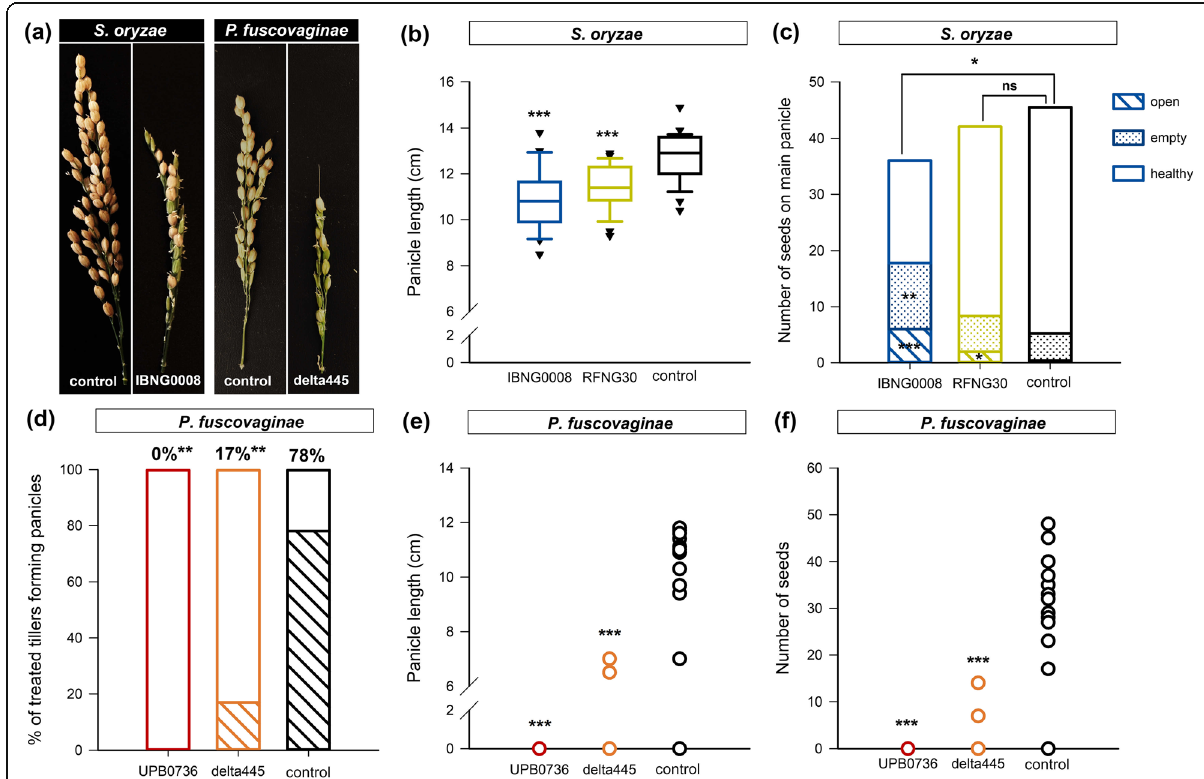
Fig. 7 Grain yield parameters of Sarocladium oryzae and Pseudomonas fuscovaginae infected plants. The main tiller of 7 weeks old Kitaake rice plants was inoculated with S. oryzae or P. fuscovaginae. IBNG0008 is shown in dark blue, RFNG30 in light green and the healthy control, inoculated with a healthy rice grain, in black. P. fuscovaginae wild type strain UPB0736 is shown in red, delta445 in orange and as a healthy control, shown in black, a sterile saline solution was injected. ( a ) A fully ripened panicle, 6 or 8 weeks after inoculation with respectively S. oryzae and P. fuscovaginae. ( b ) Boxplots represent the length of the main panicle and ( c ) stacked bars show the average amount of open, empty and healthy seeds on the main panicle of plants inoculated with S. oryzae . Yield parameters of plants inoculated with P. fuscovaginae are represented by ( d ) stacked bars showing the proportion of the inoculated tillers forming a panicle and dots represent the length of the main panicle ( e ) or the amount of seeds produced by the main panicle of each sample ( f ). The boxplots show the median with the first and third quartile, the whiskers show the minimum and maximum values. Outliers and extreme values are represented by crosses. These data show the results of one experiment with 25 replicates ( b-c ) or 18 replicates ( d-f ). Conditions that differ significantly from healthy control plants are represented by asterisks (Mann Whitney or Mood ’ s Median, n = 18 or n = 25, α = 0.05 ( a-c, e-f ). Asterisks mark conditions that influence panicle